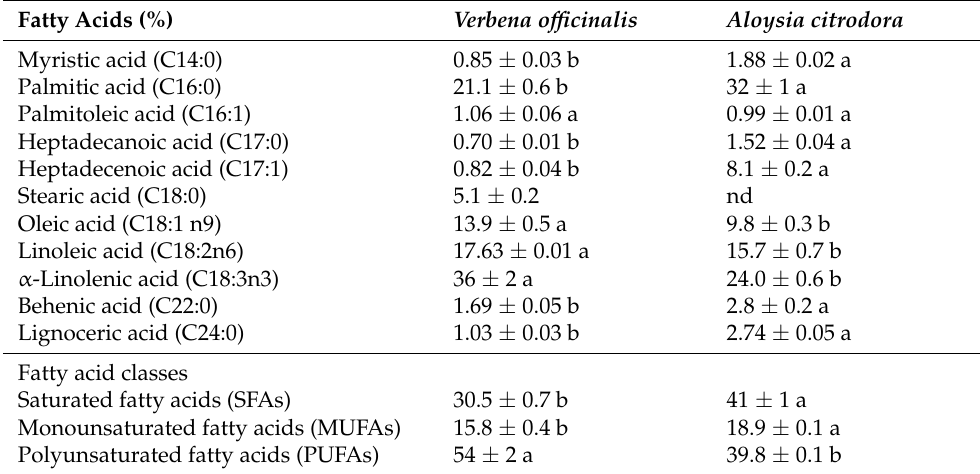
Table 3. Fatty acid composition of Verbena officinalis and Aloysia citrodora